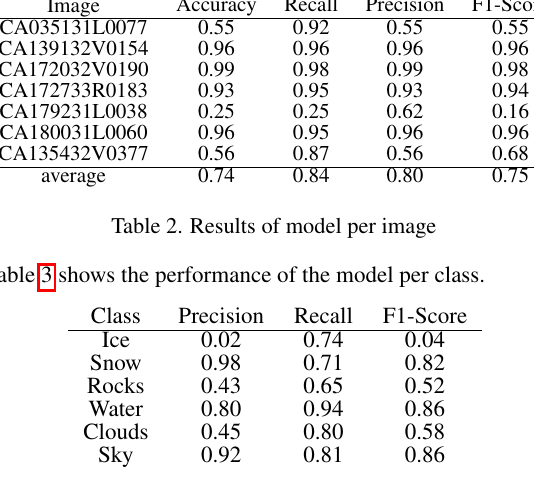
Table 3. Results for model per class